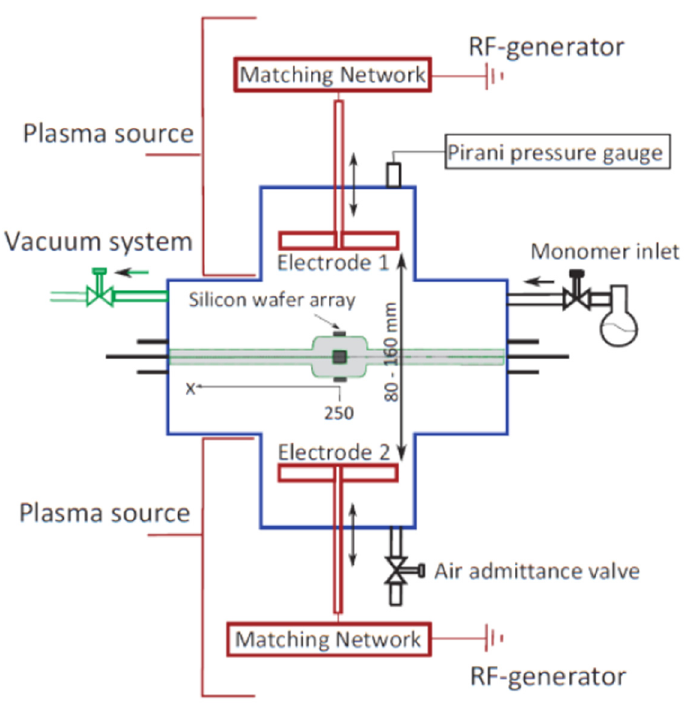
Figure 4. Schematic top view diagram of the RF PECVD chamber.